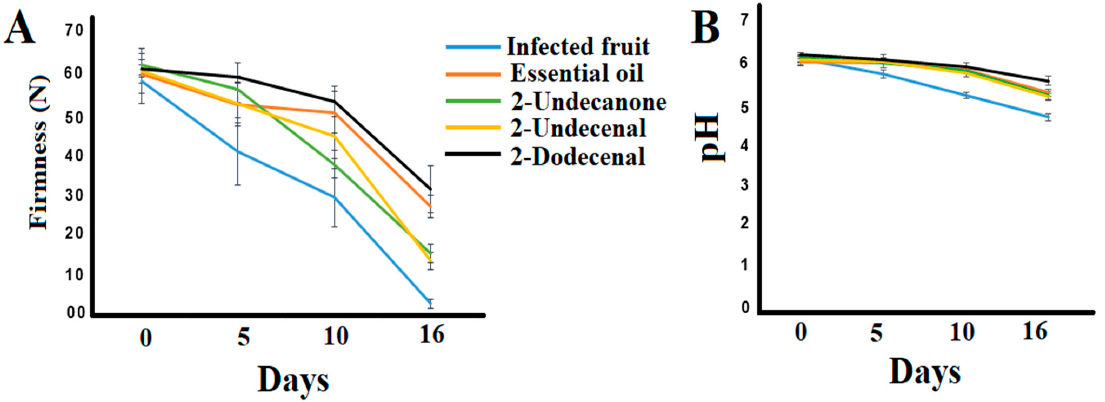
Figure 5. Protective effect of 120 mg L − 1 ZlEO, 150 mg L − 1 2-undecanone, 220 mg L − 1 2-undecenal, and 130 mg L − 1 2-dodecenal on the fruit firmness ( A ) and pH ( B ) of manzano peppers during 16 d.